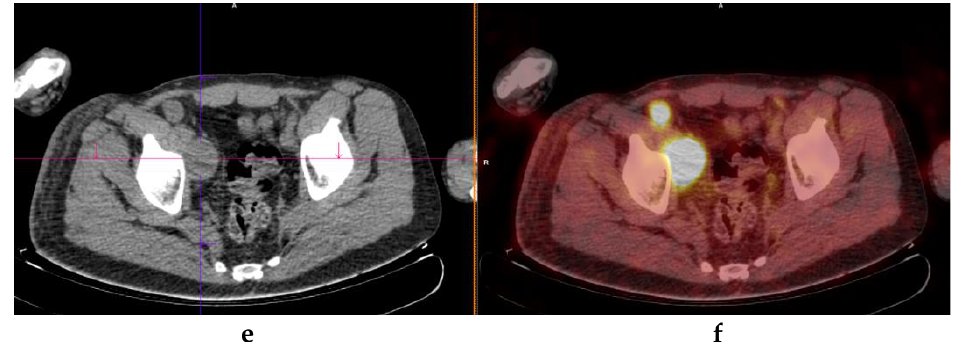
Figure 4. Classic KS. An FDG PET/CT showed a large hypermetabolic cutaneous lesion extending to adjacent muscles (SUV max 18.6) confirmed by MRI, pathological analysis, and associated with lymph node involvement. ( a ) CT transaxial slice; ( b ) PET transaxial slice; ( c ) Fused PET/CT transaxial slice; ( d ) MIP PET image; ( e ) CT transaxial slice: right iliac enlarged lymph nodes; ( f ) Intensely hypermetabolic lymph nodes in fused PET/CT transaxial slice.